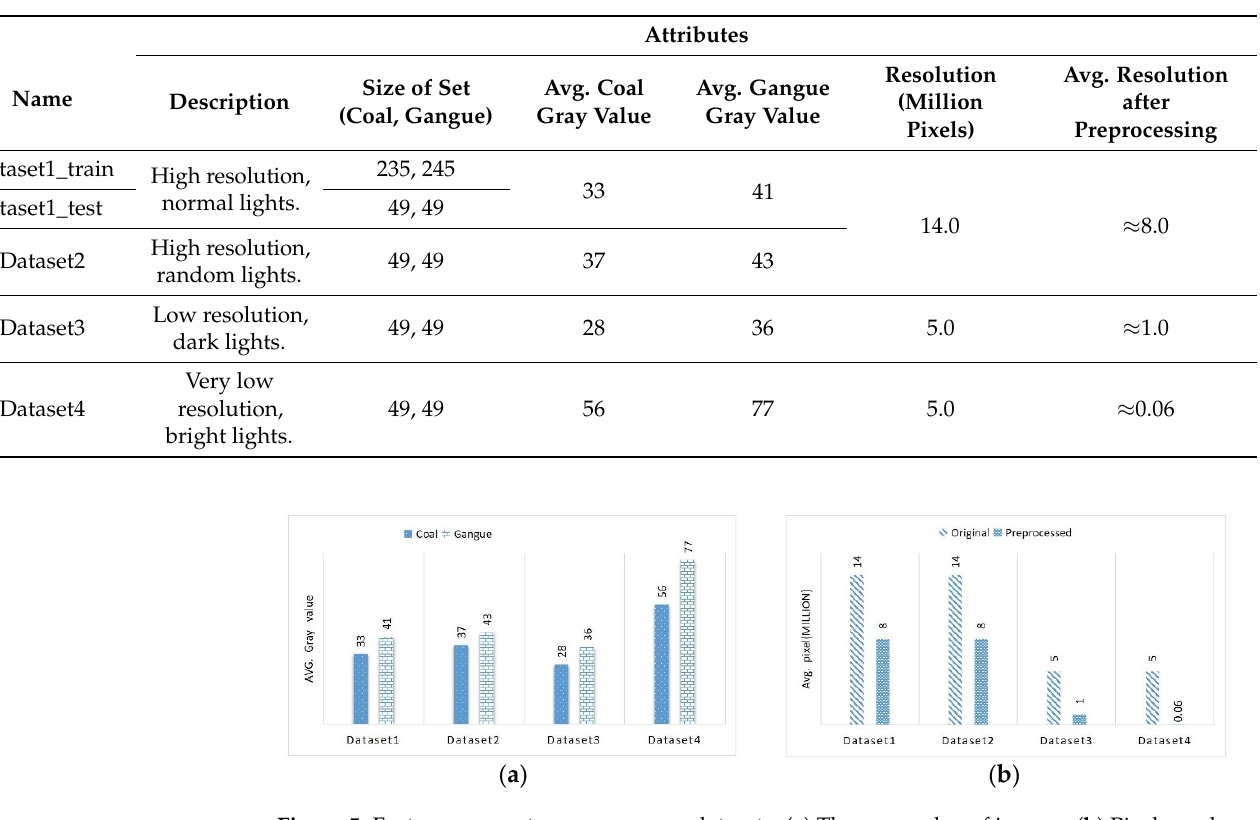
Table 1. Metadata of dataset.